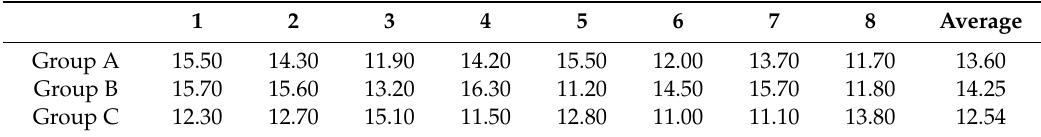
Table 1. Initial soil water content of three groups